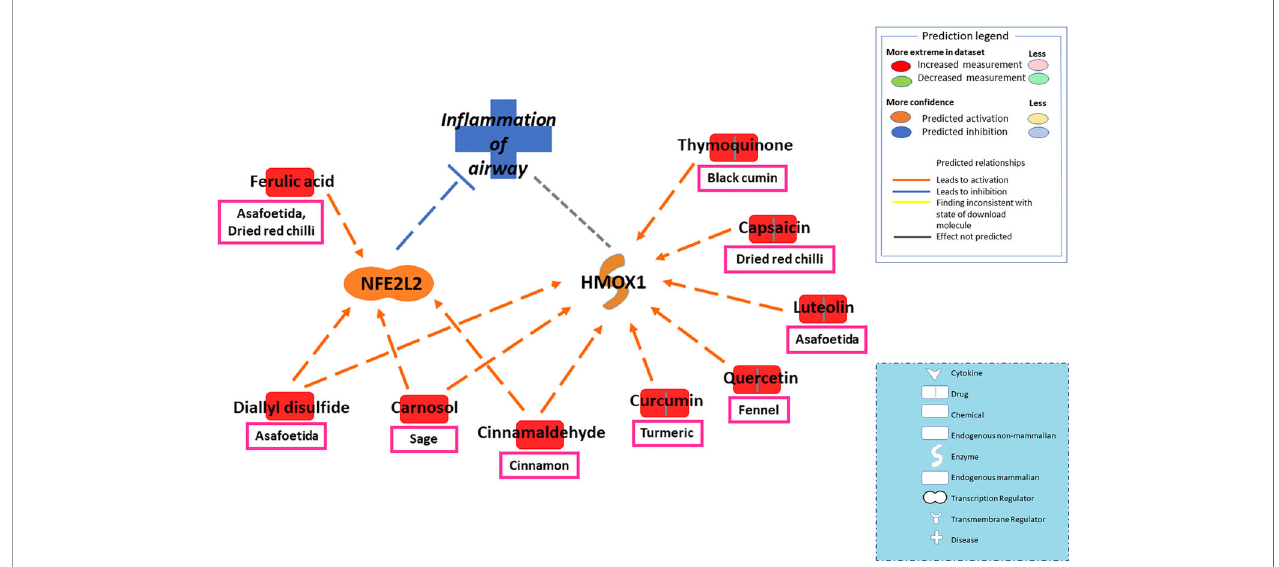
FIGURE 5 | Network depicting interactions between bioactive components in spices and major antioxidant mediators NFE2L2 (Nrf2) and Hmox1 in alleviating oxidative stress-induced airway in fl ammation. The balance between oxidative and antioxidative pathways plays a signi fi cant role in protecting against viral-induced tissue damage. In the molecular mechanism of antioxidant pathways, Nrf2 (nuclear factor erythroid 2-related factor 2) is a major antioxidant molecule that regulates a wide array of genes involved in oxidative stress and in fl ammation. The antioxidant gene Heme oxygenase 1 or Hmox1 also lies downstream of Nrf2. Spice-derived bioactive components such as ferulic acid, cinnamaldehyde, carnosol, and diallyl disul fi de could activate Nrf2, which in turn could attenuate oxidative stress-induced lung damage. Furthermore, Hmox1 can also be activated by several bioactive components, including Nrf2 activators- cinnamaldehyde, carnosol, and diallyl disul fi de. The dashed line is a potential prediction for interaction between Hmox1 and airway in fl